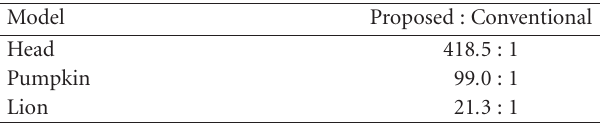
Table 1: Ratios of the number of data that can be embedded. Model